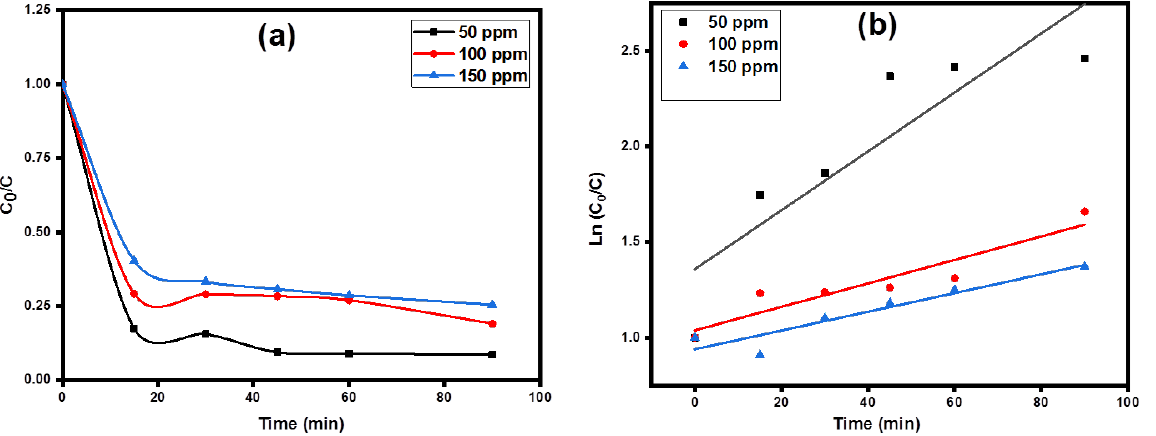
Figure 5. ( a ): Effect of diclofenac concentration on its photocatalytic activity under solar light using HDTMA@Smectite-TiO 2 . [Photocatalyst]: 0.5 g/L (0.02 ∗ 40), contact time 90 min, ( b ) Linear plot of the kinetic data based on the parameters in Equation